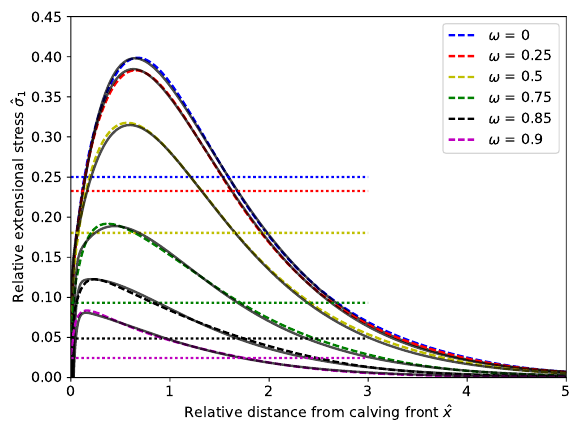
Figure 10. Modeled (dashed lines) and corresponding parametrized (solid lines) maximum extensive stresses b σ 1 at the surface for dif- ferent water depths. The dotted lines show the horizontal deviatoric stresses at the calving front for all water depths based on Eq.